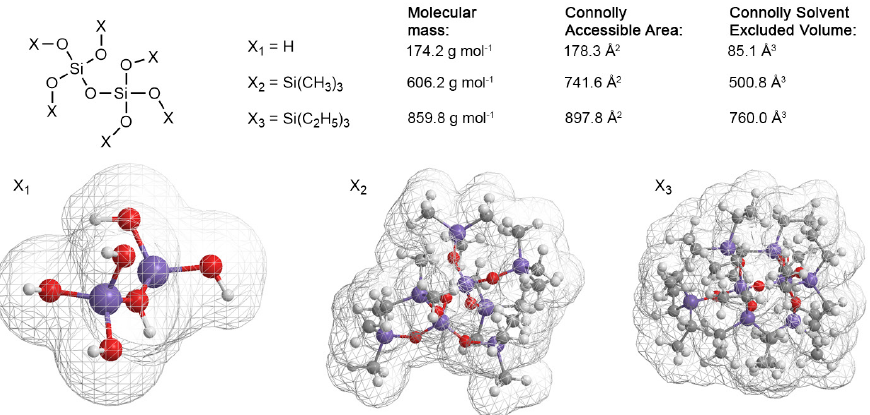
Figure 8. Sketch of the influences of a surface modification on an unmodified sample (X1), via TMCS or HMDS (X2) or TECS (X3) on the overall molecular structure. Here, a chain with two silica atoms is shown with the calculated molecular masses, accessible areas, and Connolly volume inaccessible by a solvent with a radius of 0.5 Å. The grid of the 3D structures represents the volume inaccessible by this solvent. This illustration is a simplification and values should be considered with care.